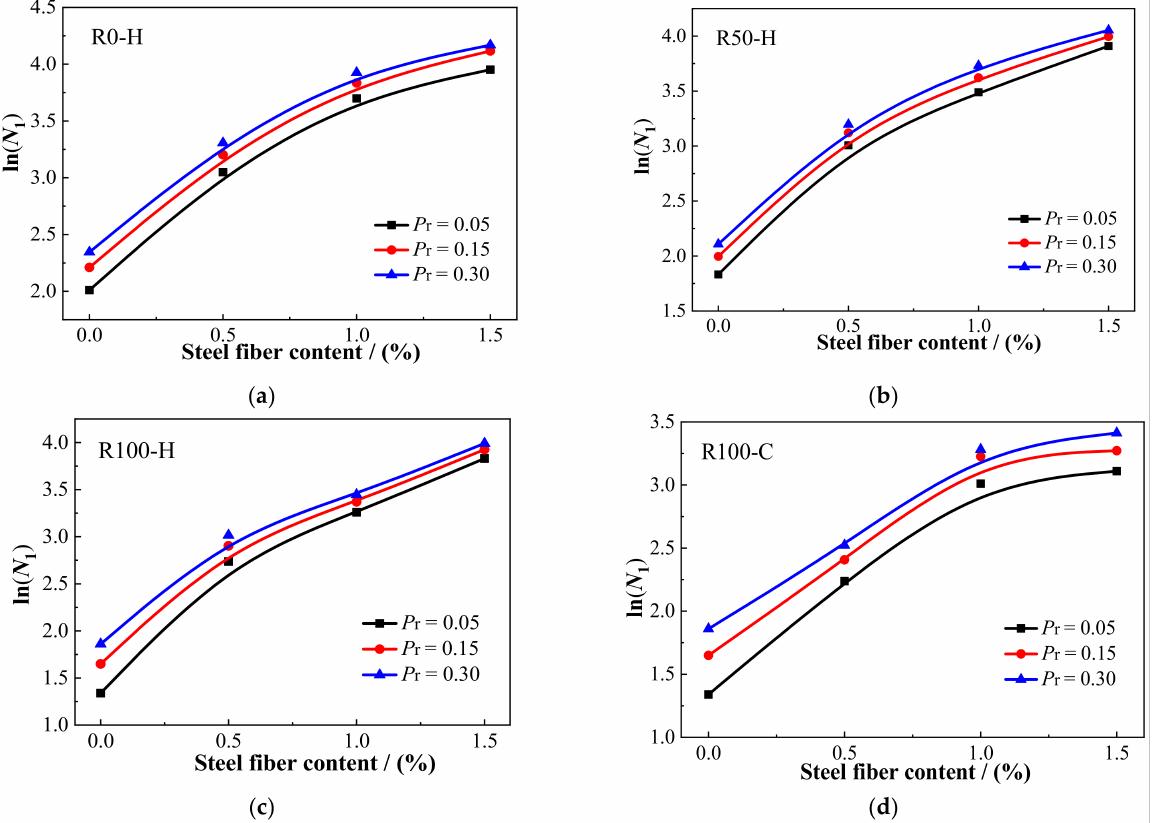
Figure 13. The curves of P r – N 1 – V f : ( a ) R0-H; ( b ) R50-H; ( c ) R100-H; ( d )